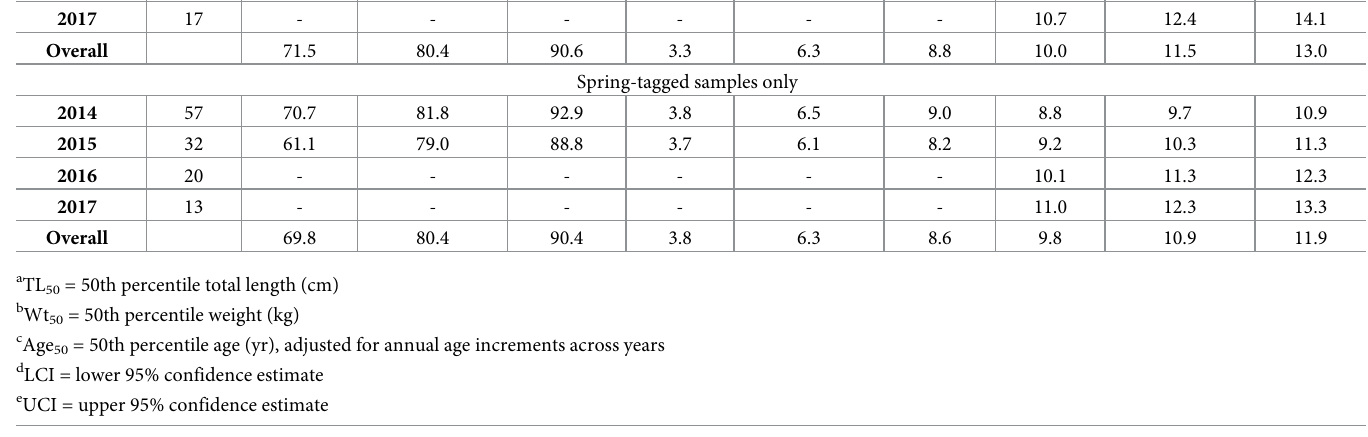
during November-January for the 2014 release group. Loss of NY Bight receivers in 2015– 2017 curtailed evaluation of seasonal migrations. Still, the sequential progression of rapid spring ocean migration over a 60 d period, to extended summertime occurrence in Massachu- setts water, to a slower southward migration (~90 day period) held for each year. Note the lack of summertime incidence off DelMarVa. In contrast, this area appears to support winter occurrences, particularly evident in 2016, when the US Navy array substantially expanded in shelf regions adjacent to the mouth of the Chesapeake Bay (Fig 1). Increased ocean incidence of fish released at < 80 cm TL occurred with each successive year as these fish grew into the larger size class predicted to migrate (Fig 6). in all study years (Fig 6). Year-round residency was observed in the Potomac River and the upper portion of the Chesapeake Bay, but was not observed for the lower portion of the Chesa- peake Bay. A minority of larger fish also persisted in the Chesapeake Bay in each year.